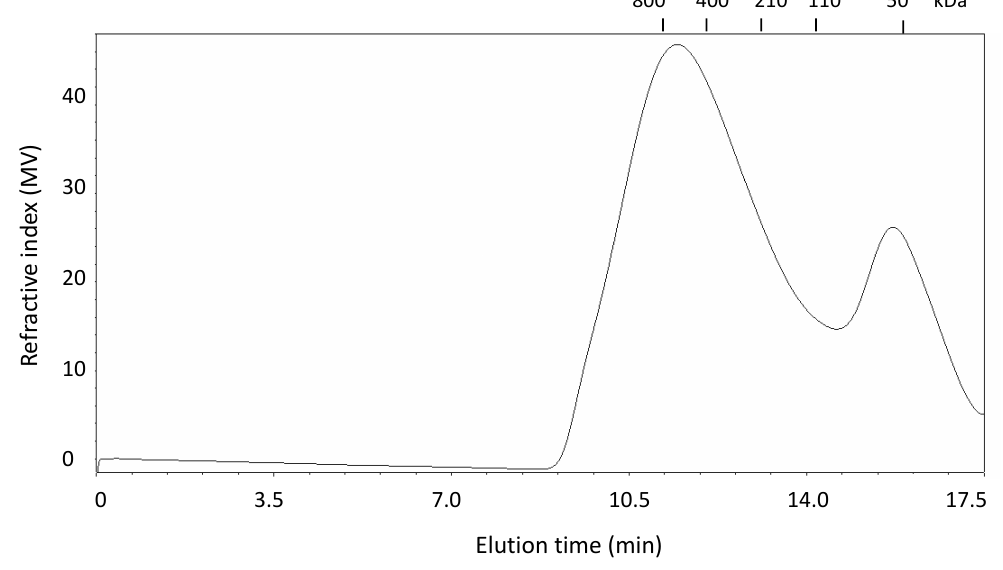
Figure 2. Elution profiles of WEAX. Pullulan molecular weight markers (kDa) used as calibration scale are shown at the